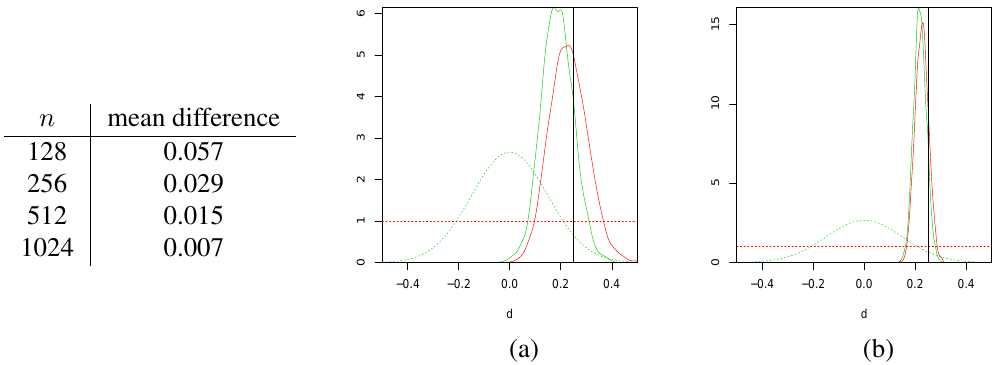
Figure 4. Table: mean difference of estimates ˆ d ( B ) under alternative prior assumption. Plots: comparison of posteriors (solid lines) obtained under different priors (dotted lines). Time series used: ARFIMA(0,0.25,0) – (a) n = 2 7 = 128, (b) n = 2 10 =